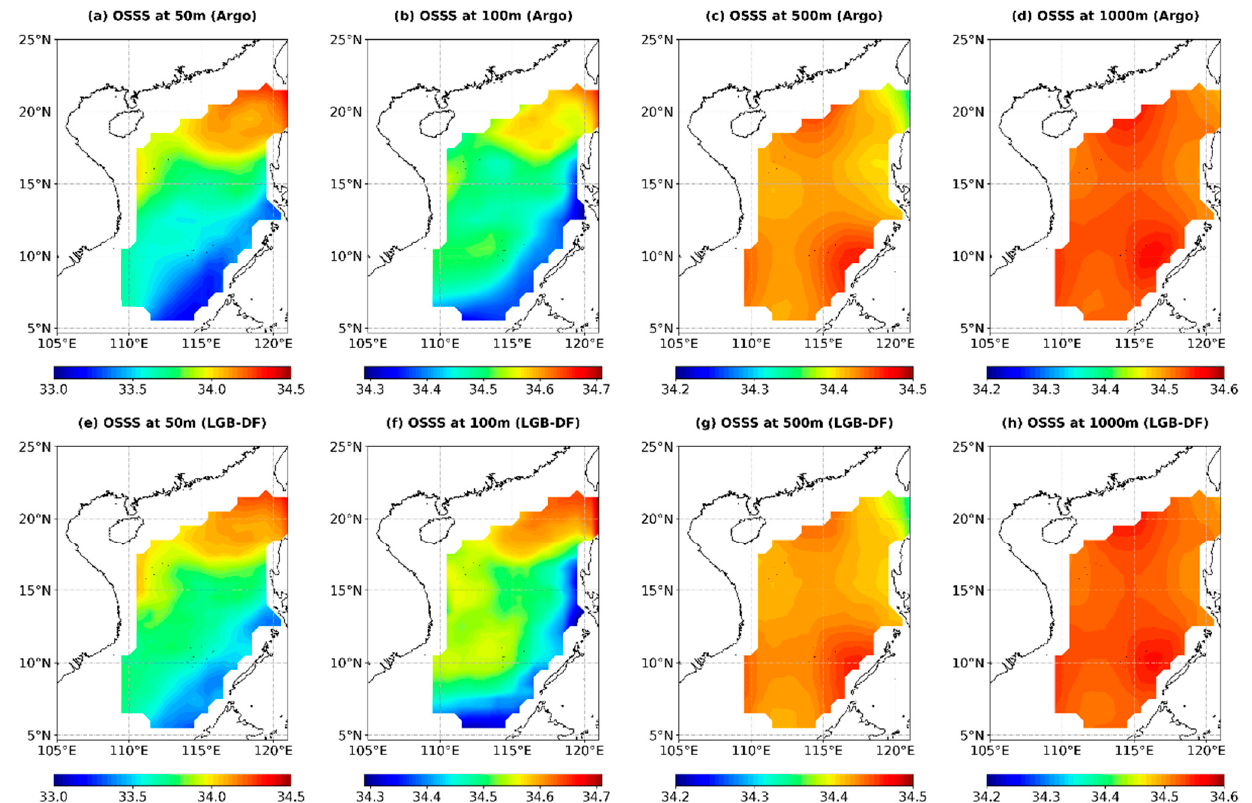
Figure 8. Argo-observed ( a – d ) and LGB-DF-estimated ( e – h ) yearly mean salinity at different depths (50, 100, 500, and 1000 m) in 2019. Table 2. Vertical distributions of RMSE (psu) and R 2 for the LGB-DF model at different depths in 2019.